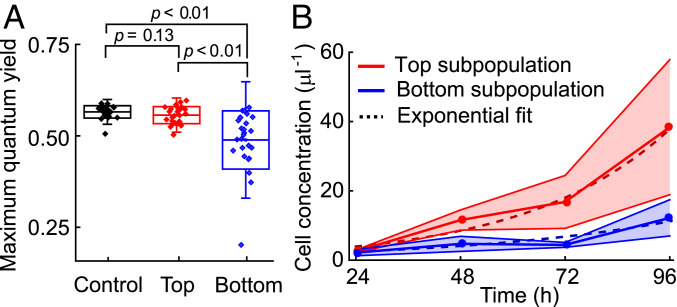
The oxidative stress induced by turbulent cues reduces photosynthetic efficiency and growth rate of H. akashiwo. (A) Maximum photosynthetic quantum yield, Fv/Fm, of H. akashiwo cells before and after turbulence-induced population splits. A PAM chlorophyll fluorometer was used to assess the maximum quantum yield of photosystem II on single cells collected from the top (n = 26) and bottom (n = 25) of the chamber after exposure to rolling (Ω = 1 rad · s−1) for 5 min and from cells not exposed to rolling (Control, n = 25). All cells were dark-adapted for 15 min before measurements. Boxes show ±1 SD, whiskers ±2 SD, and the central line indicates the mean. Control and flipped populations differed significantly (one-way ANOVA, F2,74 = 18.8, P < 0.001). Brackets show P values from post hoc Tukey’s HSD tests (SI Appendix, Table S2). (B) Increase in cell concentration with time for the subpopulations extracted from the top (red) and bottom (blue) of the chamber after exposure to rolling (Ω = 1 rad · s−1) for 5 min (mean ± SD of three replicates). Cells were regrown from the same initial density. The intrinsic growth rate, g, was quantified for each subpopulation by fitting an exponential function (dashed curves; g↑ = 0.74 ± 0.02 d−1, g↓ = 0.47 ± 0.03 d−1).